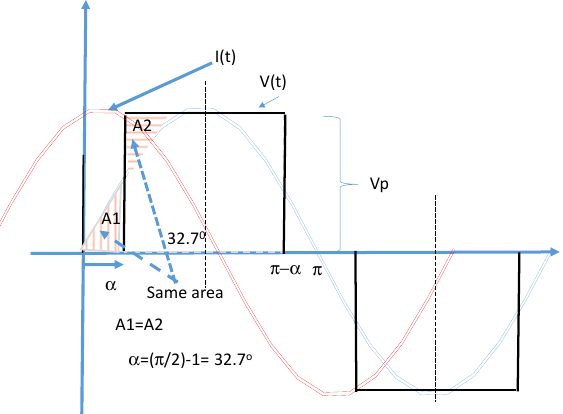
Figure 6. Square voltage injection and equalized area for harmonics content minimization.